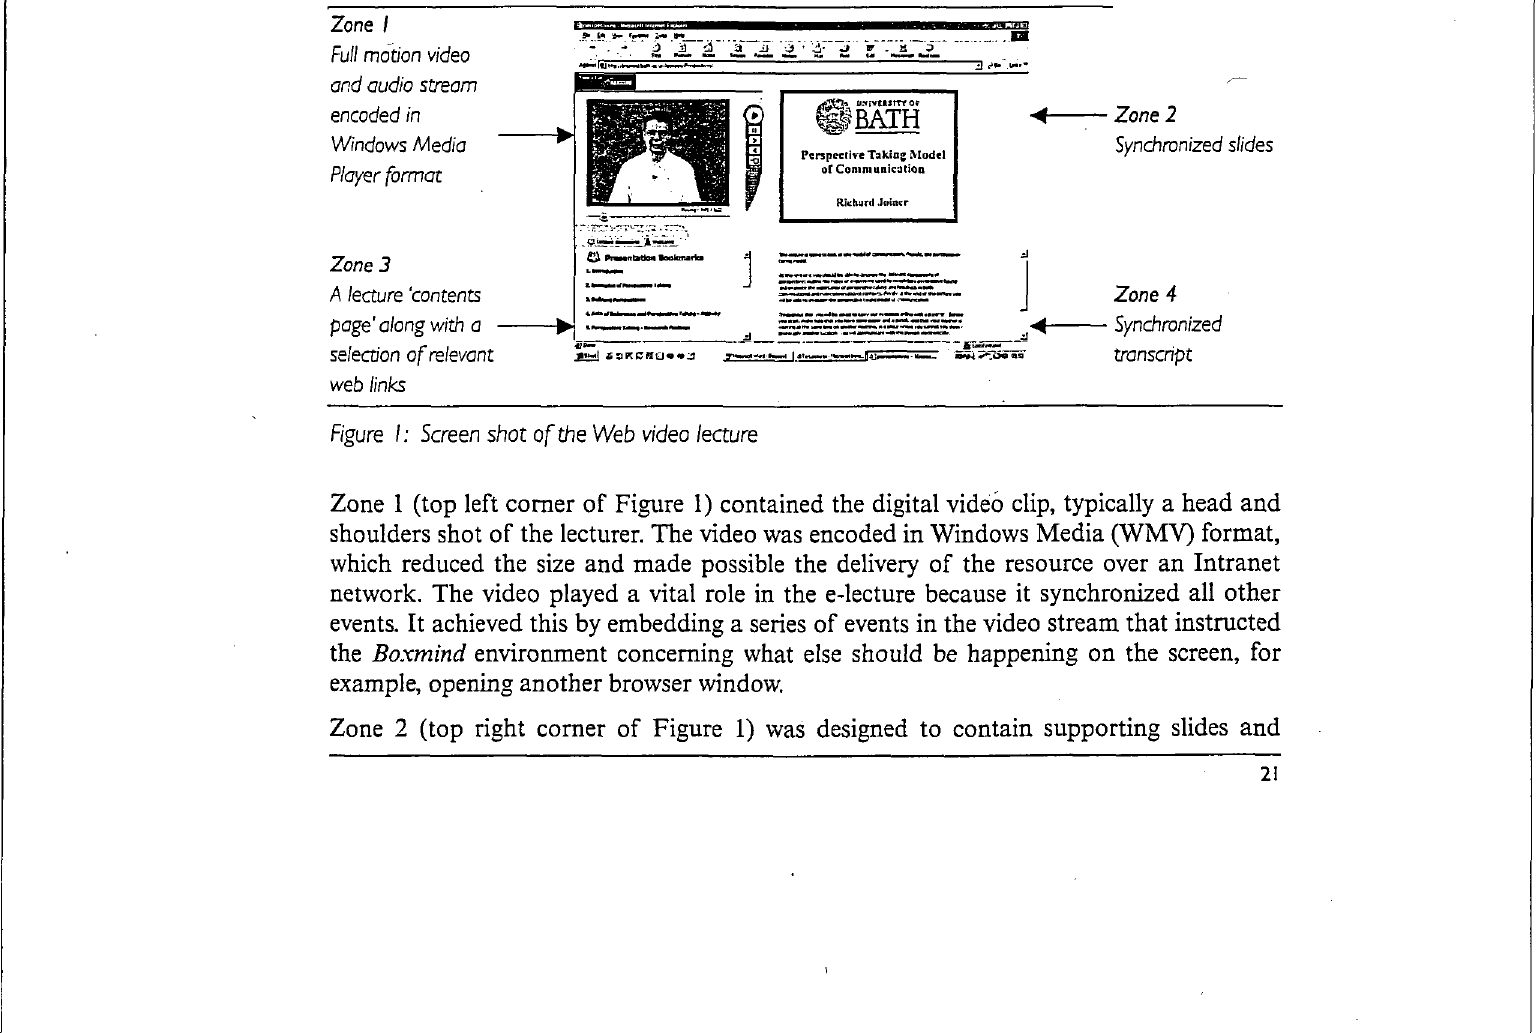
Figure I: Screen shot of the Web video lecture Zone 1 (top left corner of Figure 1) contained the digital video clip, typically a head